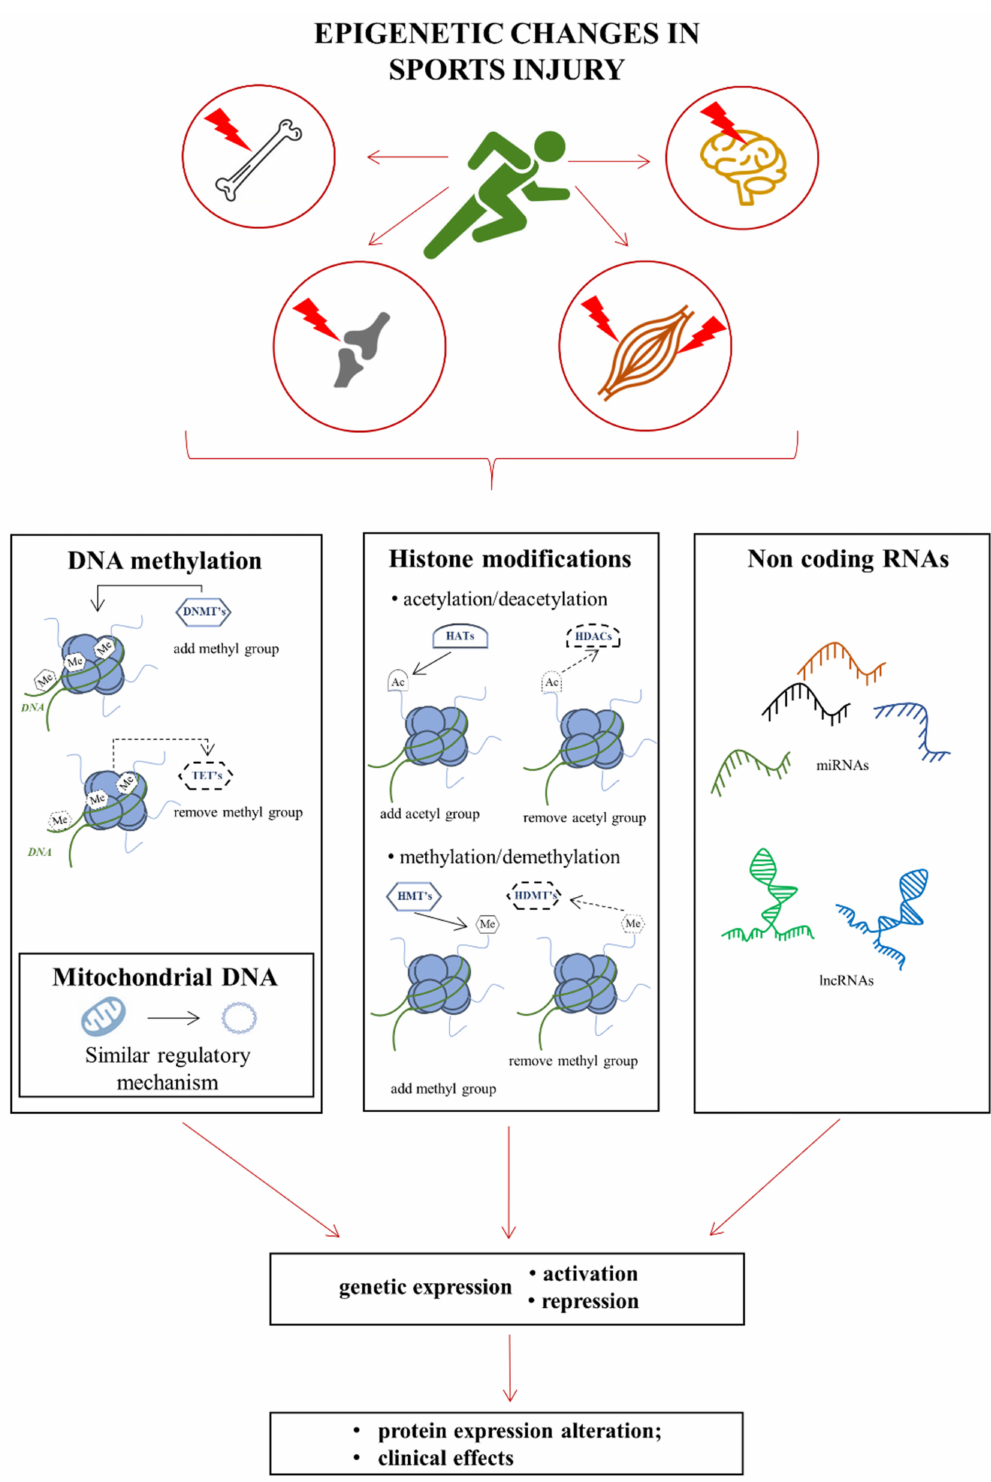
Figure 1. Epigenetic modifications as a result of sports-related